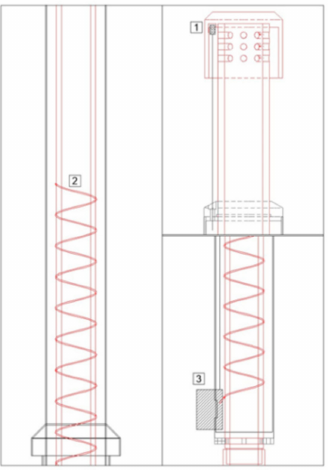
Figure 3. Diagram of the RG temperature control system: external temperature sensor (1), heating system (2), electronic controller board